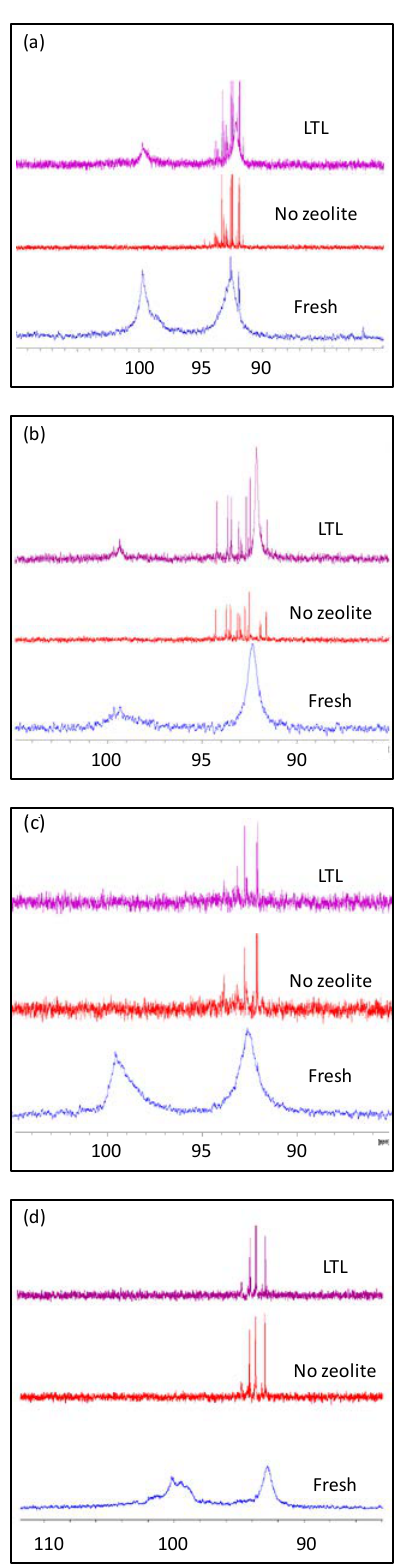
Figure 2. 31 P NMR spectra of ( a ) SA-C2, ( b ) SA-C3, ( c ) SB-C2, and ( d ) SB-C3 in their fresh form (blue) or following 24 h of oxidation at 150 °C in absence (red) or presence (violet) of LTL nanozeolite.